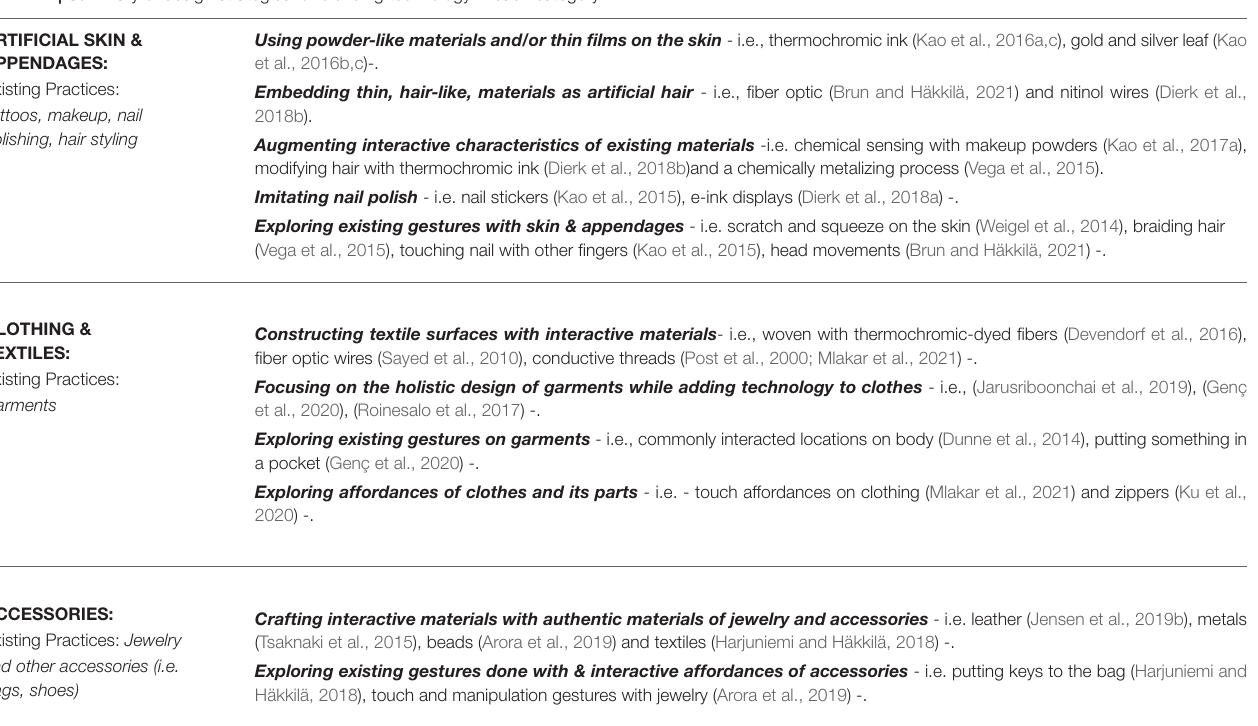
TABLE 1 | Summary of design strategies for blending technology in each